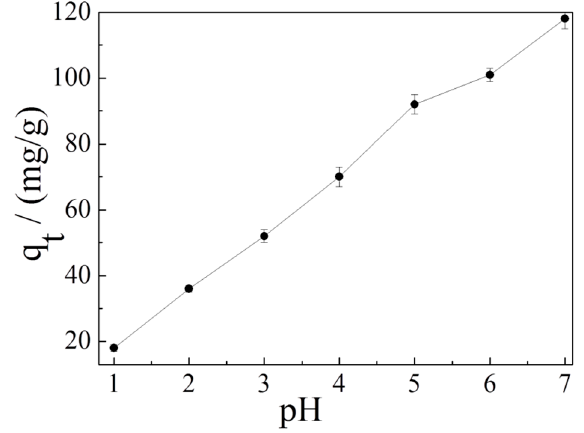
Figure 7. Effect of pH on the adsorption of Cd 2+ ion on K-Ac.